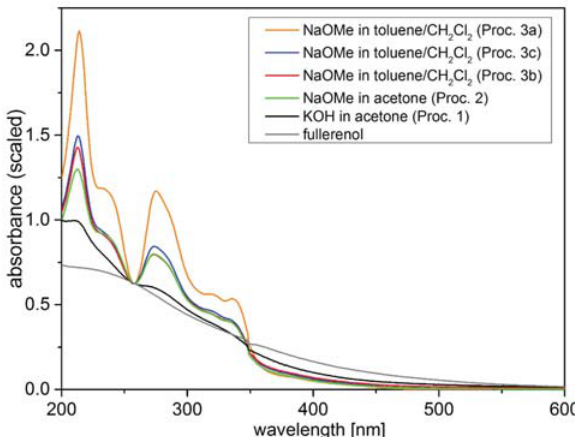
Figure 1. UV/Vis absorption spectra of samples hydrolyzed at dif- ferent conditions. Spectra were recorded in water at 25 °C and li- nearly scaled to have the same absorbance at 258 nm (local mini- mum in spectra of low deteriorated samples; chosen arbitrary as a reference point). Discontinuity of spectra at 350 nm is due to the change of light source in the spectrophotometer. The concentration of fullerene species in all solutions was of the range 10 –5 mol